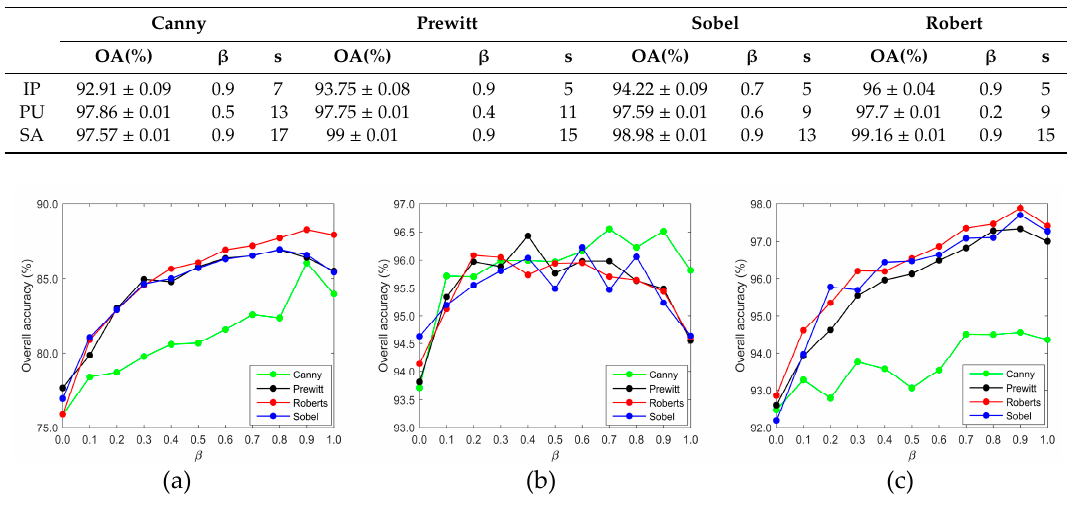
Figure 10. The variation of the average classification accuracy with the increase of β . (a) Indian Pines. (b) Pavia University. (c) Salinas.